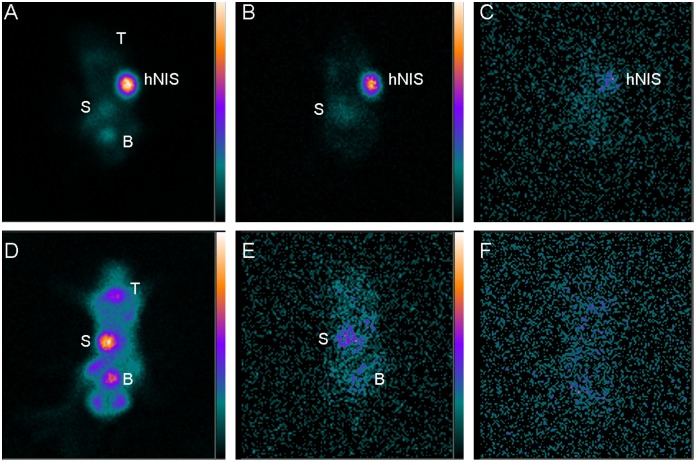
Whole-body scintigraphic images (anterior view) of hNIS-expressing U87-hNIS tumors (the first line, right axilla) or U87-0 tumors (the second line, right axilla) at 1-hour (A, D), 24 hours (B, E), and 48 hours (C, F) after intravenous injection of 188Re. T = thyroid; S = stomach; B = bladder; hNIS = hNIS-expressing tumor.